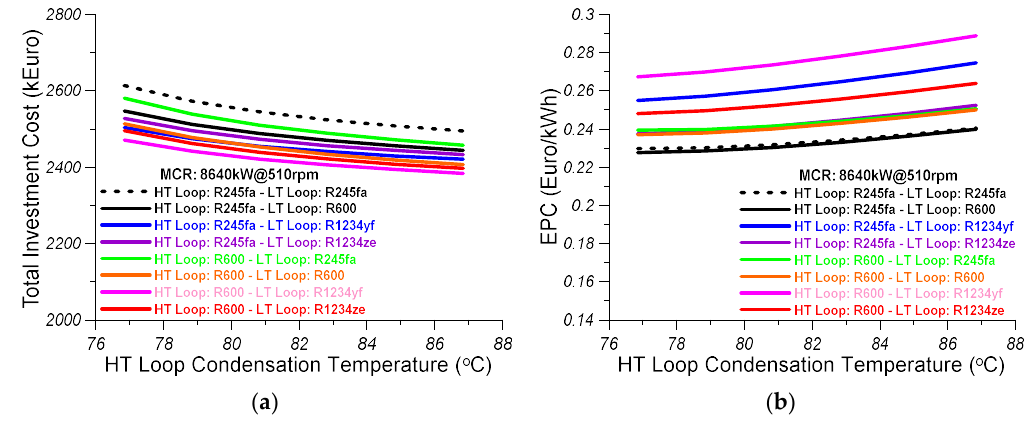
Figure 12. (a) Effect of the condensation temperature of the HT loop on the total investment cost